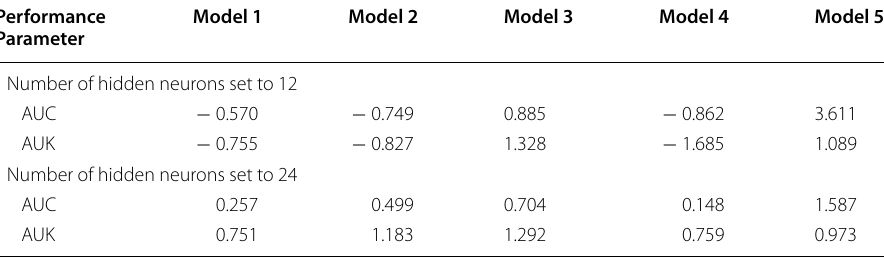
Table 4 Performance parameters, sensitivity, and precision of the decision